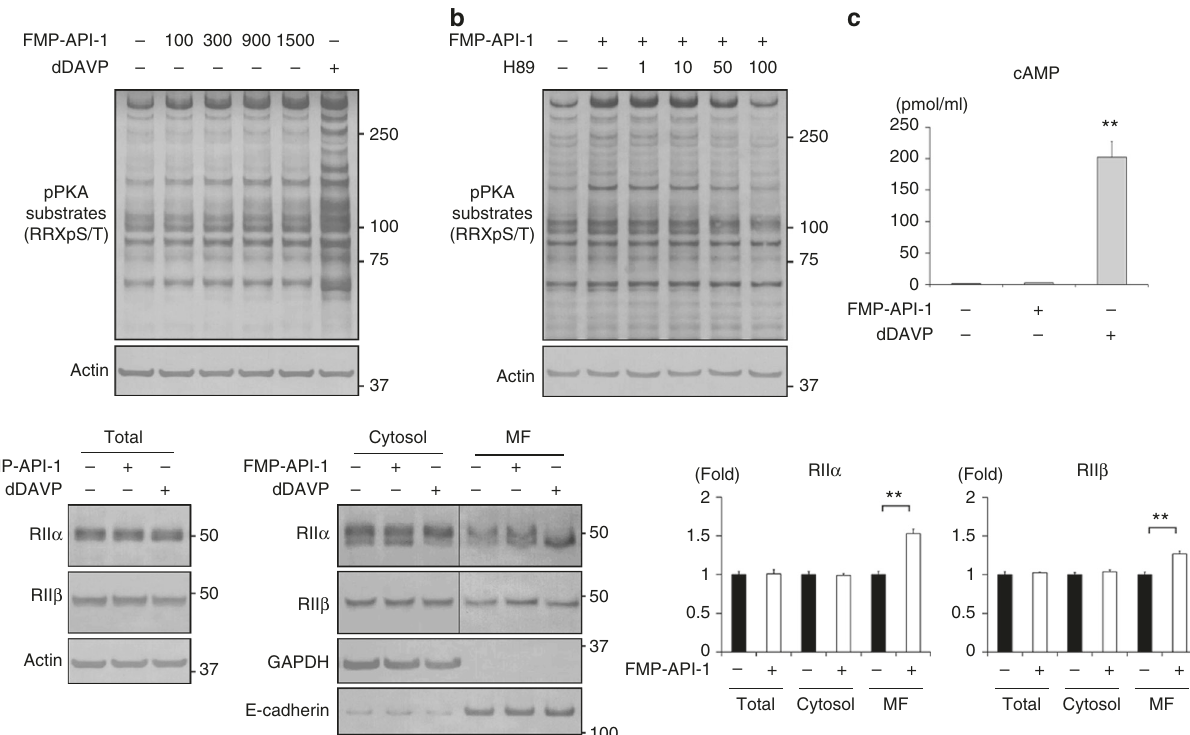
Fig. 3 FMP-API-1 increases PKA activity without elevation of cAMP. a Dose-response studies of FMP-API-1. FMP-API-1 (100 – 1500 µ M) was added to the basolateral side of the mpkCCD cells for 1 h. Representative blots of three independent experiments are shown. b Dose-response studies of H89. FMP-API- 1 (900 µ M) was added in the presence or absence of H89 (1 – 100 µ M) for 1 h. The mpkCCD cells were pretreated with H89 for 1 h before FMP-API-1 stimulation. Representative blots of three independent experiments are shown. c No signi fi cant elevation of cAMP concentration in response to FMP-API-1. The mpkCCD cells were treated with FMP-API-1 (900 µ M) for 1 h. Bars are mean values ± SD of three experiments. Asterisk indicates a signi fi cant difference, as compared with the control. Tukey, ** p < 0.01. d The effects of FMP-API-1 on PKA localization. (Left) FMP-API-1 (900 µ M) was added to the basolateral side of the mpkCCD cells for 1 h. The mpkCCD cells were then incubated with 1% Triton X-100 for 3 min before cell lysis and divided into a detergent-soluble cytosol fraction and an insoluble membrane fraction. Representative blots of three independent experiments are shown. (Right) Bands of PKA RII α / β were quanti fi ed by densitometric analysis, and the results are presented in the bar graphs as the fold change, as compared with the values of the control cells. Bars are mean values ± SD of three experiments. Tukey, ** p <